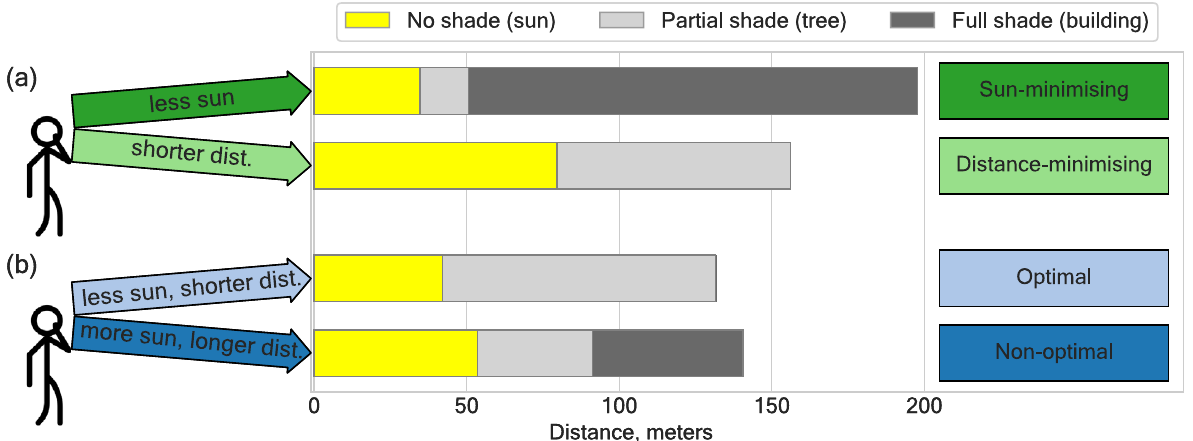
Figure 2. Parameters of path options define possible path choice strategies. Depending on the environmental conditions and the spatial configuration of path options in a particular trial, participants faced a choice either between less sunny but longer (sun-minimising) vs. sunnier but shorter (distance-minimising) options (a) ; a second type of choice was between less sunny and shorter (optimal) vs. sunnier and longer (non-optimal) options (b) . The choices between sun-minimising and distance-minimising options (a) allow us to quantify the trade-off between sun exposure and walking distance in the process of pedestrian path choice behaviour. The figure is generated with use of package matplotlib v3.2.2 (https:// matpl otlib. org/) for Python